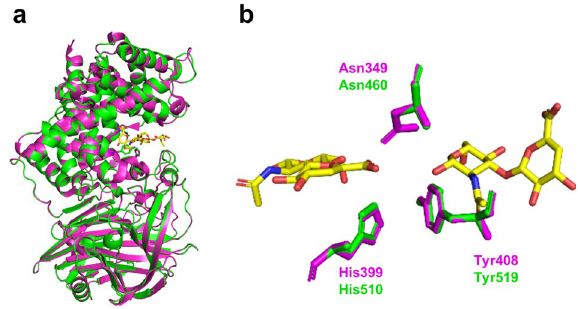
Figure 7. Comparison of HA lyases of G. adiacens and S. pneumoniae . ( a ) SWISS-MODEL homology modeling of LPXTG-motif cell wall anchor domain protein of G. adiacens (GadHL), based on the crystal structure of HA lyase of S. pneumoniae (SpnHL2, PDB ID 1c82). ( b ) Superimposition of the catalytic sites for HA lyase activity. Green, GadHL; magenta, SpnHL2; yellow, HA disaccharide units. Homology modeling suggested the conservation of the catalytic sites for the